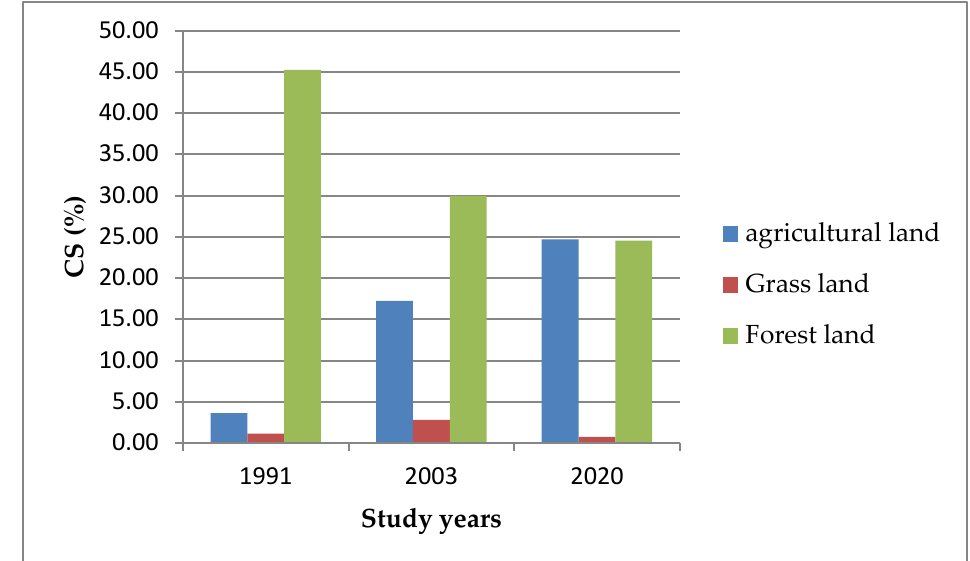
Figure 6. Coefficient of sensitivity analysis for 1991, 2003, and 2020 in the Matenchose watershed.